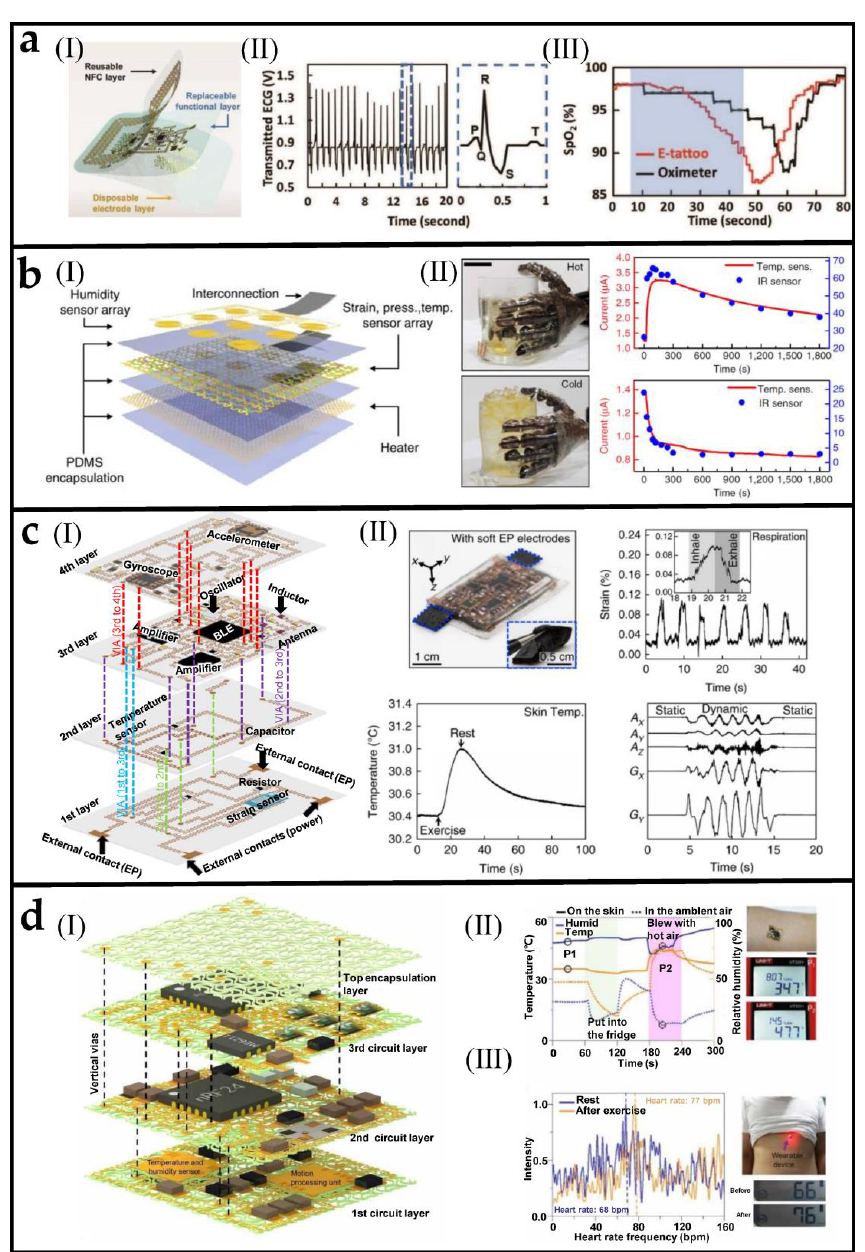
Figure 5. Stacked integrated multifunctional sensors. ( a ) ( I ) Schematic of the modularized e-tattoo. ( II ) Wirelessly measured ECG by the e-tattoo. ( III ) SpO2 measured wirelessly by the e-tattoo (red) and by a commercial oximeter (black) before. Reprinted with permission from [110]. Copyright 2019 Wiley − VCH. ( b ) ( I ) An exploded view of the artificial skin comprised six stacked layers. ( II ) Images of the prosthetic limb touching a cup of hot and iced water. Reprinted with permission from [111]. Copyright 2014 Nature Publishing Group. ( c ) ( I ) Exploded schematics of the system fabricated layer by layer. ( II ) An optical image of the system integrated with CNT/silicone and the output signals of strain, temperature, and acceleration. Reprinted with permission from [112]. Copyright 2018 Nature Publishing Group. ( d ) Design and fabrication of densely packed, a stretchable electronic system based on SMNM and demonstration of functional characteristics of the SMNM-based electronic system ( I ) Schematic illustration of the device system in an exploded view. ( II ) Temperature and relative humidity measured by SMNM-based electronic system. ( III ) Results of heart rates extracted from the frequency analysis of accelerometer data, obtained from the device. Reprinted with permission from